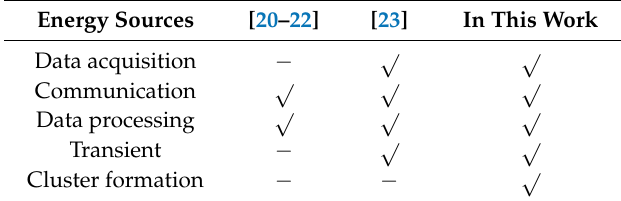
Table 1. Recently used energy model.